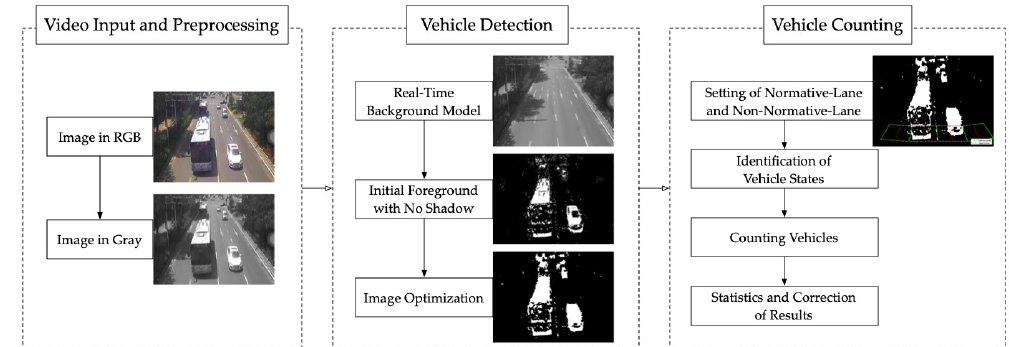
Figure 1. Block diagram of the proposed framework.